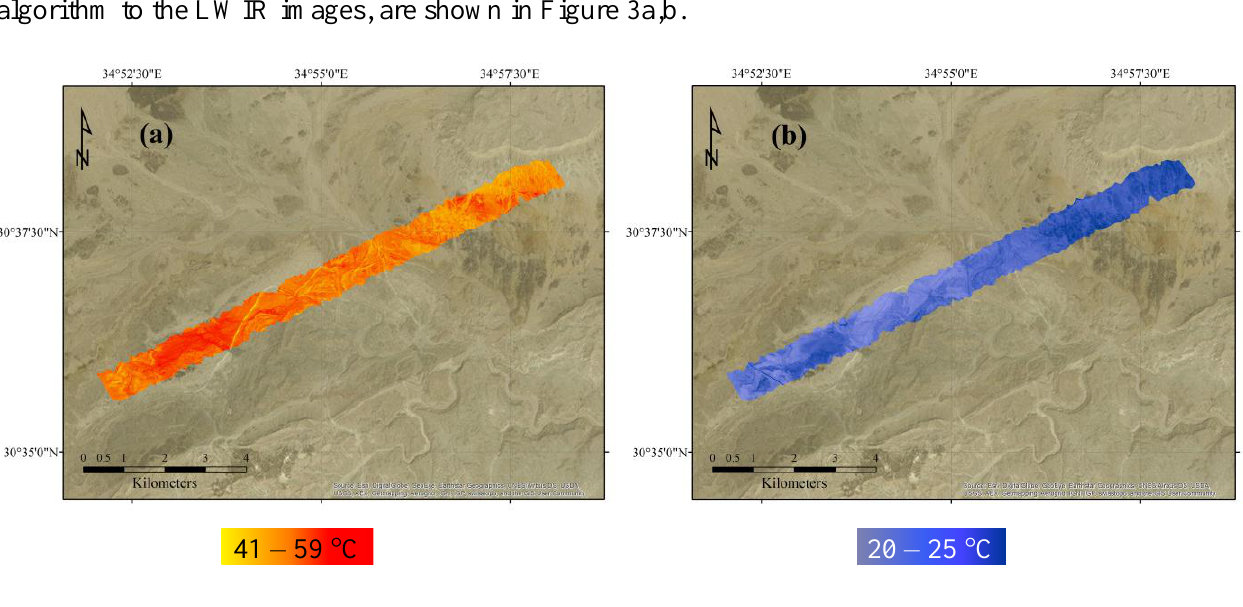
Figure 3. ( a ) Day and ( b ) night surface temperature images as derived from the LWIR images. The hot surface in the daytime and the cold surface at night, compared to air temperatures of 32–22 °C, respectively, indicate a surface with low thermal inertia, suitable for applying the suggested